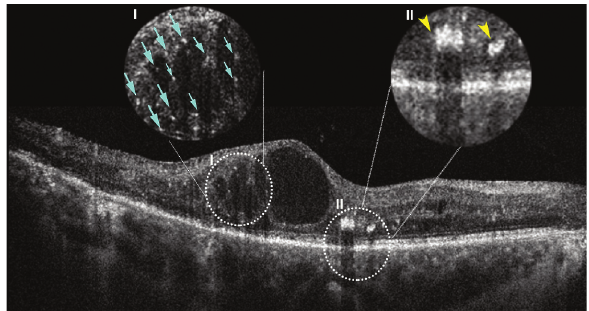
Figure 1: Spectral-domain optical coherence tomography B-scan showing the morphological differences between the inflammatory hyperreflective foci (Inset I is characterized by small size ( ≤ 30 μ m), the absence of posterior shadowing, inner and outer retinal lo- cation, and the reflectivity similar to the retinal nerve fiber layer ( light blue arrows ), and other subtypes of hyperreflective material (Inset II) such as retinal exudates are characterized by preferential location in the outer retinal layers, size > 30 μ m, the presence of posterior shadowing, and reflectivity similar to the retinal pigment epithelium ( yellow arrowheads